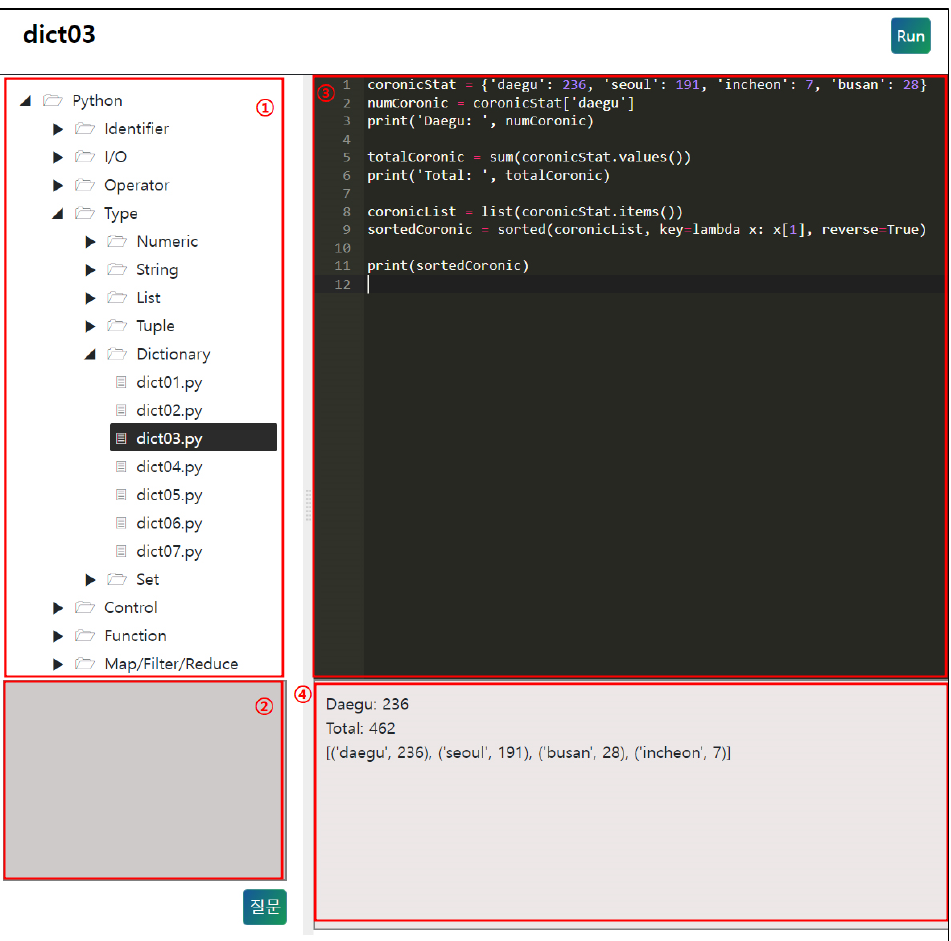
Figure 1. Student interface. ① The file window shows the example source code for each unit or chapter uploaded in advance by the instructor. It is a window for selecting and editing or executing a specific file. ② The question window is for entering and sending questions to the instructor. ③ The editor window is for editing the source code, and provides syntax highlighting features. Any code changed by student input is transmitted to the instructor through the learning monitoring server. ④ The results window outputs the results of executing the source code.